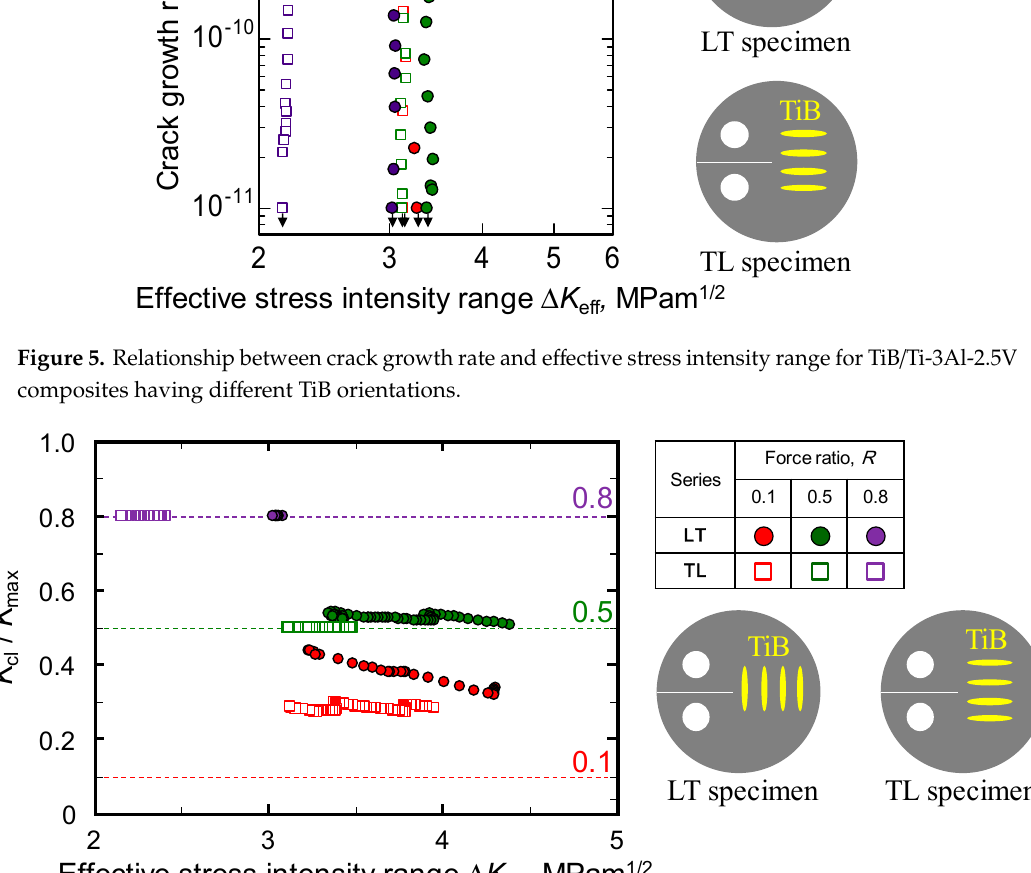
Figure 5. Relationship between crack growth rate and effective stress intensity range for TiB/Ti-3Al- 2.5V composites having different TiB orientations.